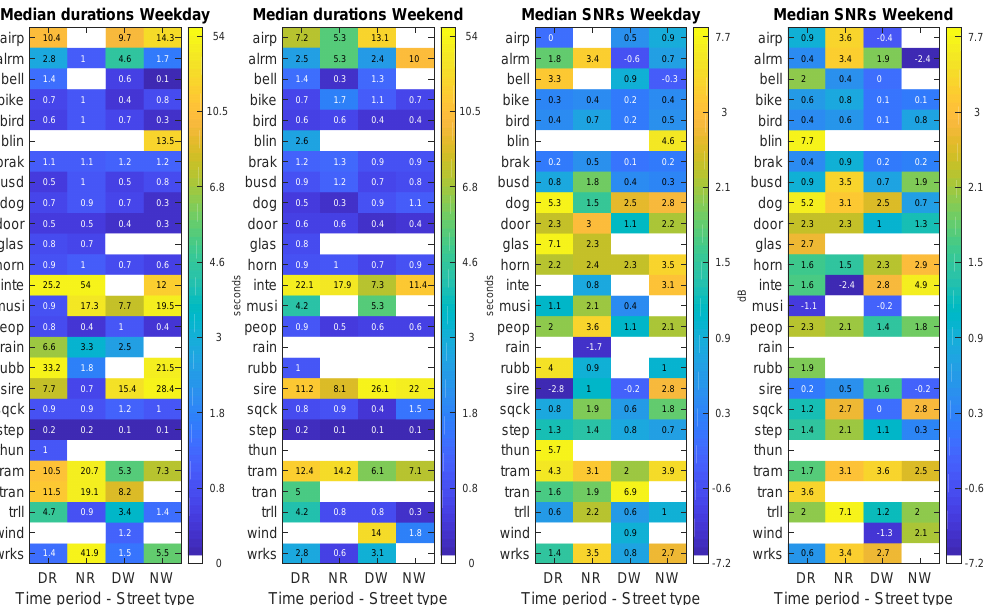
Figure 9. Results of the day–night and narrow–wide pairs analysis ( P RW weekday and weekend days for the following ANE features: median duration (two leftmost subfigures) and median SNR (two rightmost figures). Each subfigure shows the distribution of the corresponding ANE feature in terms of ANE subcategory and the pair street type and time period: Narrow–Day (RD), Narrow–Night (RN), Wide–Day (WD) and Wide–Night